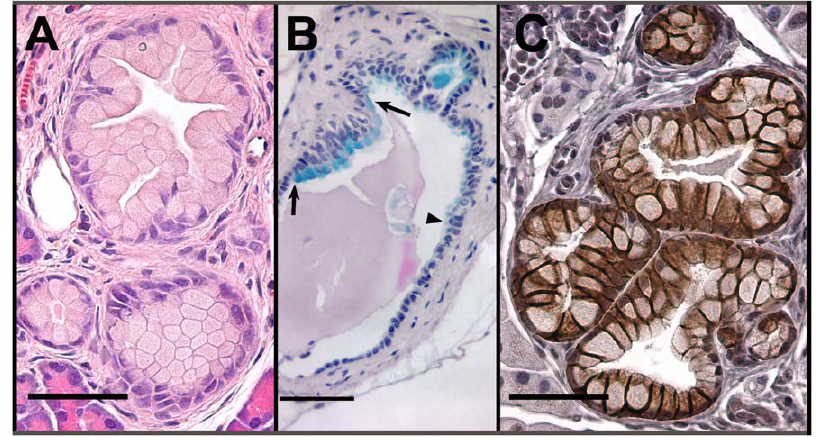
Figure 6. Kras G12D mutation led to mucinous metaplasia in pancreatic ducts. H&E staining of a typical lesion in mouse pancreas (A) and its connection to normal ductal epithelium in a nearby serial section (B) with alcian blue staining to denote mucin-producing cells. Arrowhead, junction between nonmucinous and mucinous cells; arrows, junction between cuboidal and columnar cells. (C) Mucinous lesions were all strongly positive for claudin-18 (brown) with highest concentrations along lateral cell borders. Size bars, 50 m